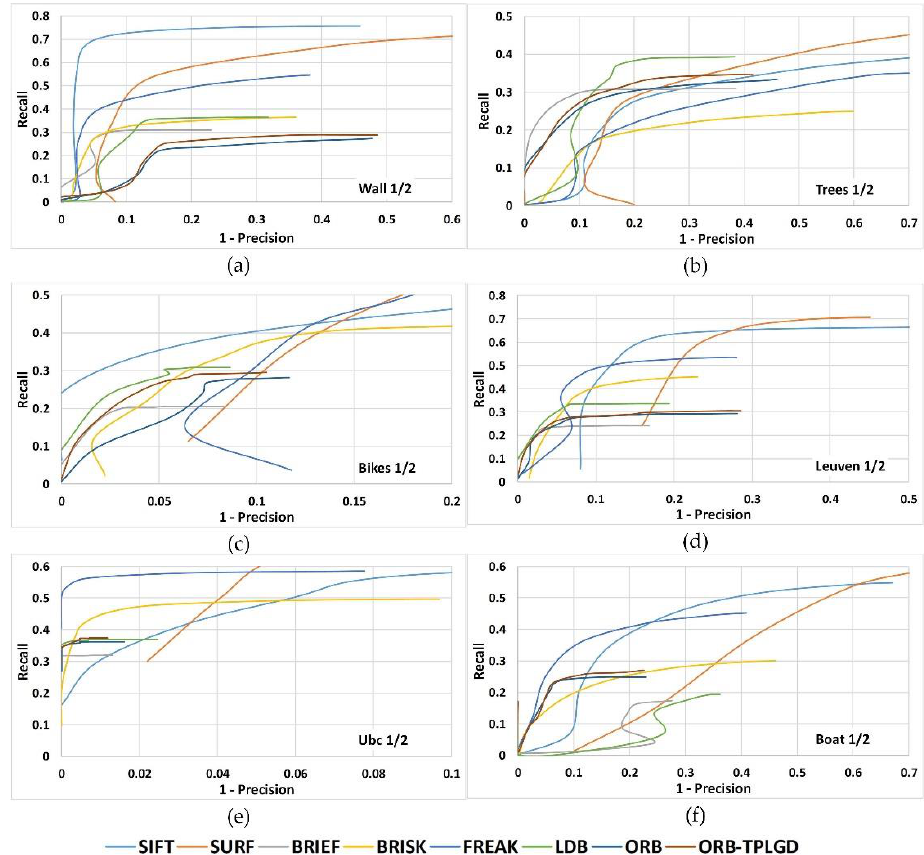
Figure 9. Recall versus 1-precision curves for image pairs 1 / 2 of all six image sequences. ( a ) Wall (viewpoint), ( b ) Trees (blur), ( c ) Bikes (blur), ( d ) Leuven (illumination), ( e ) Ubc (JPG compression), ( f ) Boat (rotation and scale). Table 4. Average matching precision based on Oxford dataset (%).